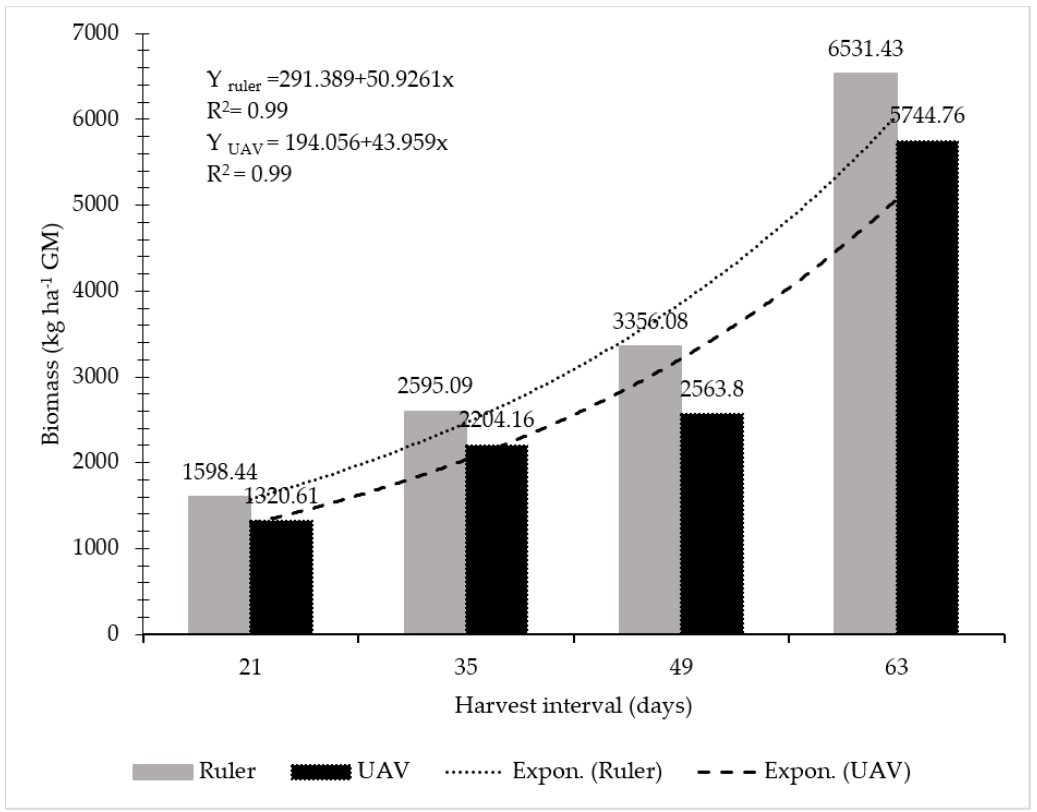
Figure 8. Biomass estimated by the ruler and by the UAV at different harvest intervals.